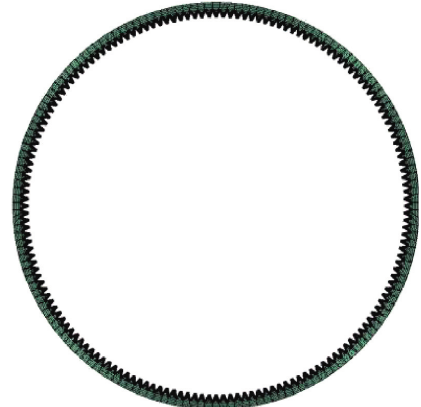
Figure 5: Finite element model of circular spline.